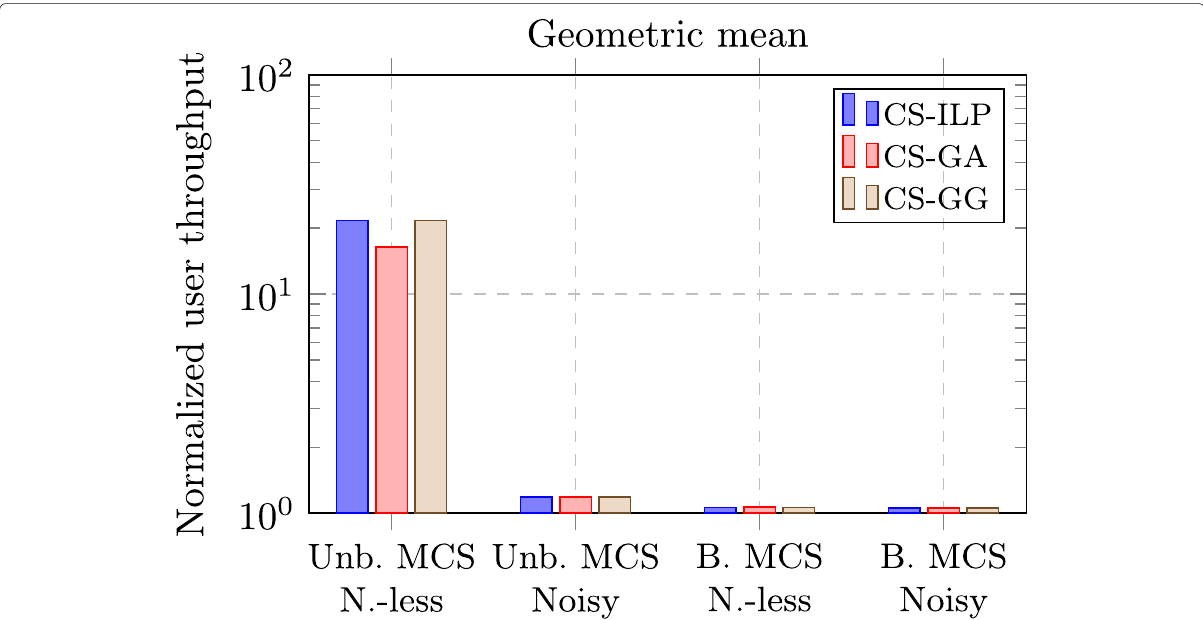
Fig. 3 Geometric mean of the average user throughput for the CoMP CS schemes, normalized with respect to the non-coop. PFS. Scenario with M = 3 BSs, N = 30 UEs, L = 10 PRBs, and M (cid:4) = 2 BSs. Four cases with limitations on the maximum achievable data rate and the noise power level are considered. There is no out-of-cluster interference